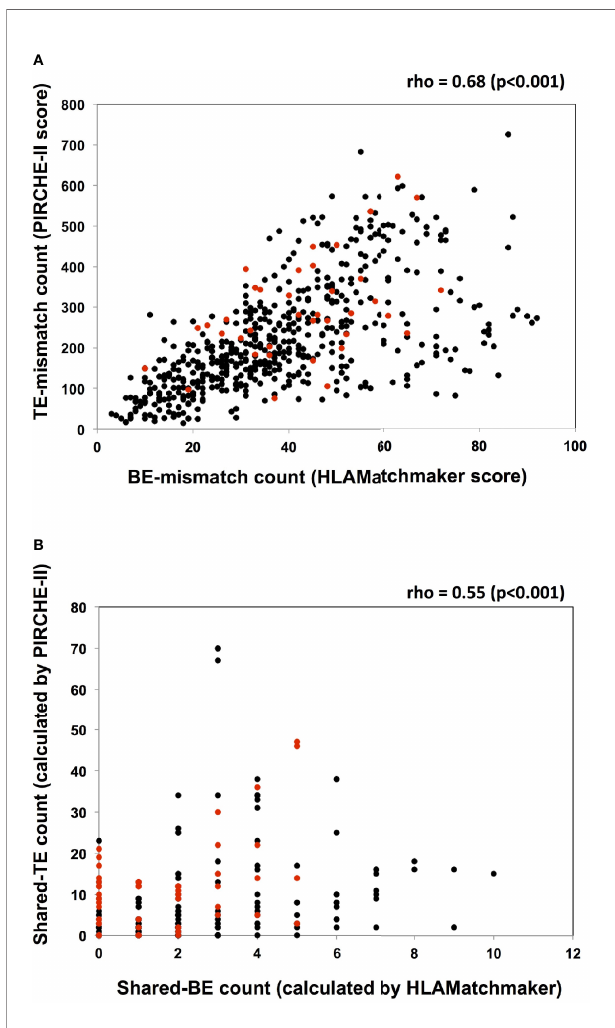
FIGURE 4 | Analyses of the association between TE and BE. (A) The TE- mismatch count (PIRCHE-II score) and the BE-mismatch count (HLAMatchmaker score) of each recipient and donor pair are plotted. A moderately positive correlation between the TE- and BE-mismatch counts is noted with a Spearman ’ s rho of 0.68 (p < 0.001). Red circles and black circles indicate the dnDSA positive and negative patients, respectively. (B) The shared- TE count (calculated by PIRCHE-II) and the shared-BE count (calculated by HLAMatchmaker) between every detected non-DSA (MFI>1000) and the donor HLA are plotted. Each characteristic of non-DSA and the corresponding shared-TE and shared-BE counts are listed in Supplementary Tables 1 and 2 . There is a weakly positive correlation between the shared-TE and shared-BE counts, with a Spearman ’ s rho of 0.55 (p < 0.001). Red circles and black circles indicate non-DSA in dnDSA positive and negative patients, respectively. dnDSA, de novo donor-speci fi c anti-HLA antibodies; non-DSA, non-donor- speci fi c anti-HLA antibodies; TE, T cell epitope; BE, B cell epitope; PIRCHE, predicted indirectly recognizable HLA